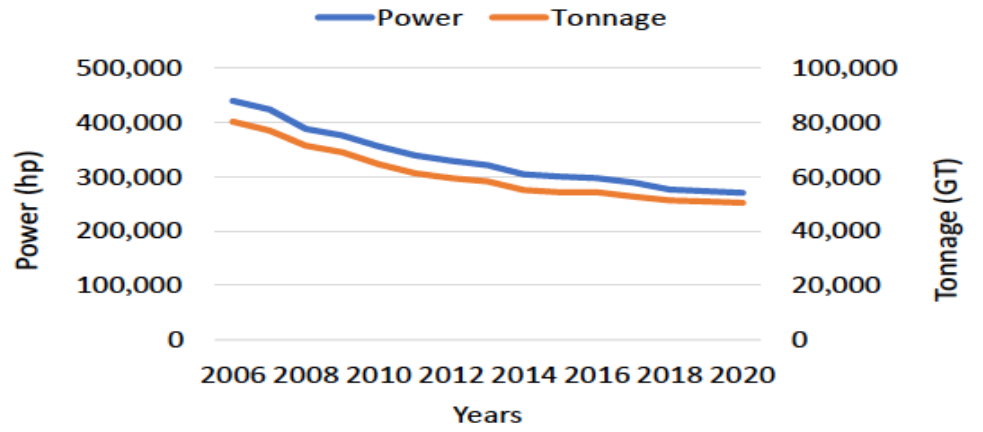
Figure 3. Evolution of the power and tonnage of the fishing fleet in the Spanish Mediterranean (2006–2020). Annual average values 4 . Table 1. Power (hp) and tonnage (GT) per boat by gear in the Spanish Mediterranean 5 .